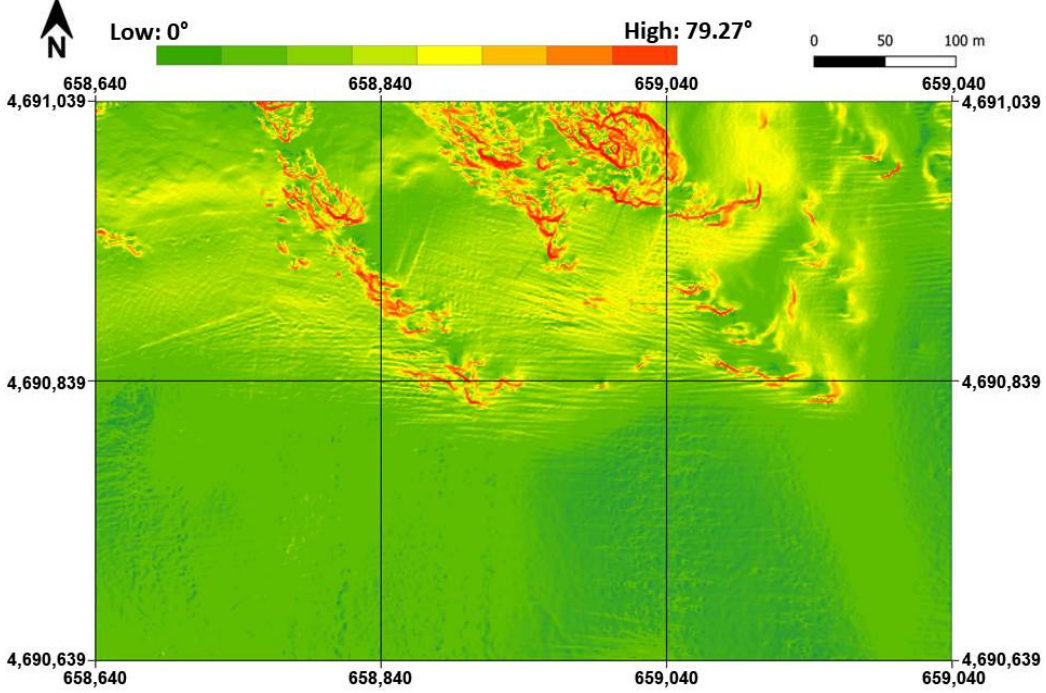
Figure 4. Slopes chart of the initial MBD in UTM/WSG 84 plane coordinates expressed in meters (EPSG: 32632).